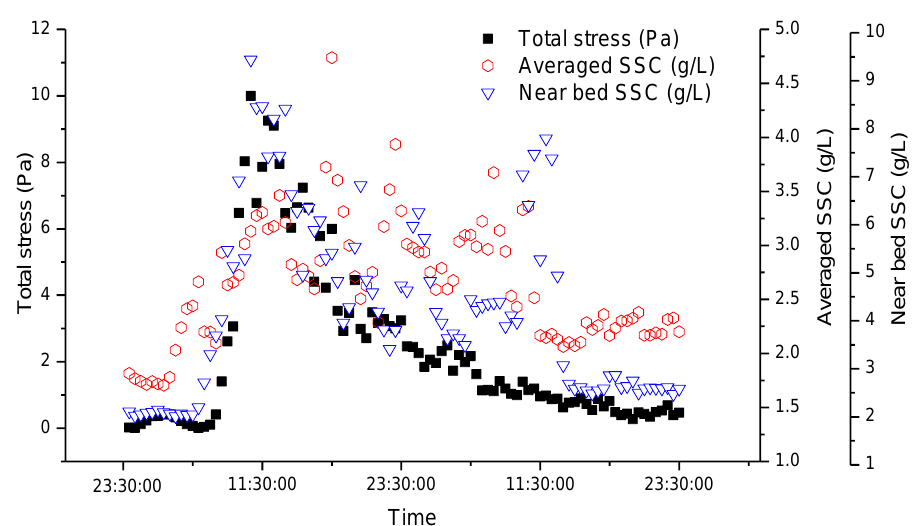
Figure 12. Changes in SSC and total stress with time during 26-27 December 2016.